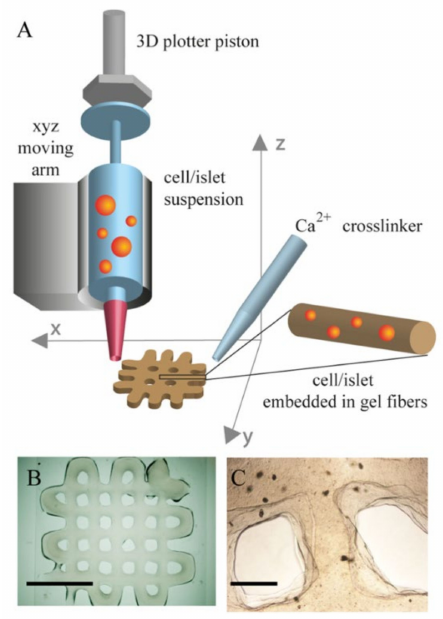
Figure 5. 3D bioprinting scaffolds. ( A ) 3D printing schematic. ( B ) alginate/gelatin 2 × 2 cm 2 plotted scaffold (scale bar 10 mm). ( C ) Image of plotted islets in the construct (scale bar 1 mm). Reprinted with permission from [164]. Copyright (2015) IOP